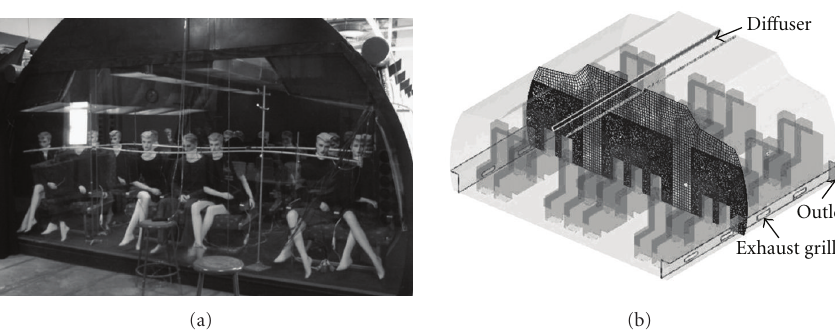
Figure 5: Study of the airborne transport of expiratory droplets in a Boeing 767-300 cabin mockup. (a) General view of the mockup with the passenger dummies (b) Computational dominium [20].